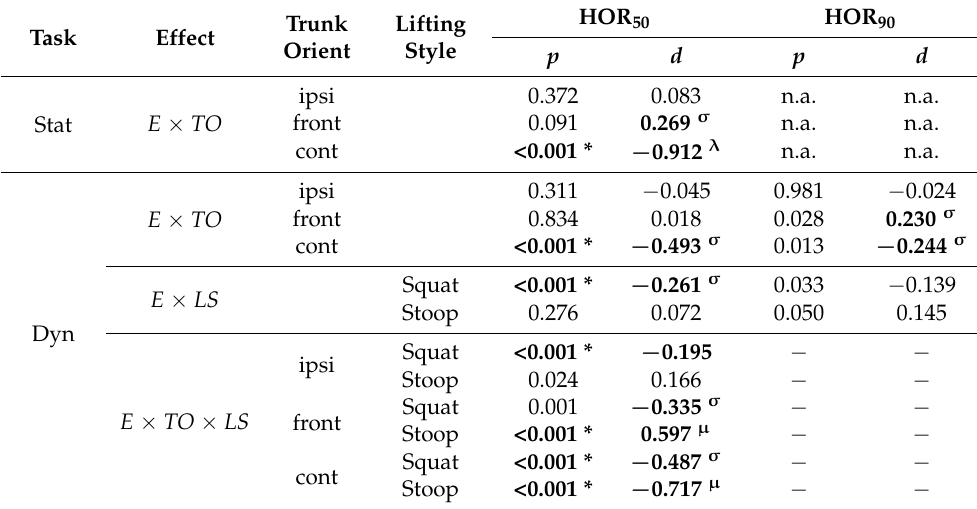
Table A6. Pairwise comparisons ( p -values and Cohens’d ( d )) for the relevant interactions between E × TO, E × LS, and E × TO × LS for variables with significant interaction effects for static and dynamic work